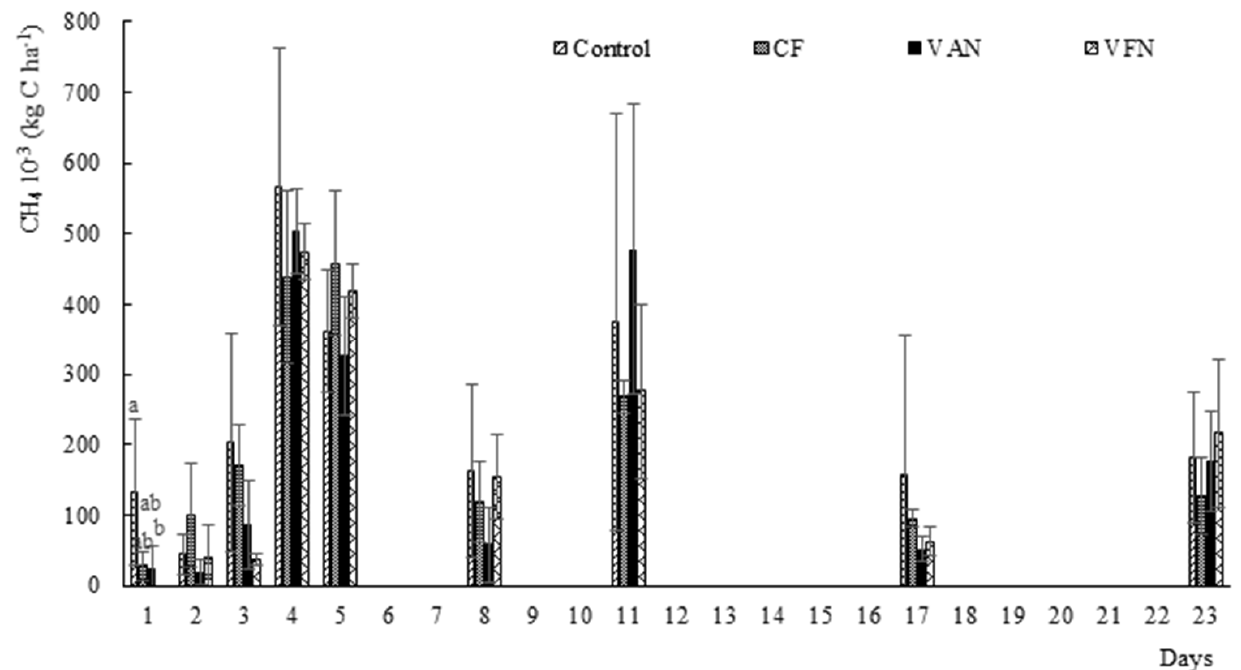
Figure 3. CH 4 emission dynamics (CH 4 10 − 3 kg C ha − 1 ) for barley in season 2018/2019. Different letters indicate significant difference, according to Dunn’s post-hoc test ( p < 0.05), between treat- ments.